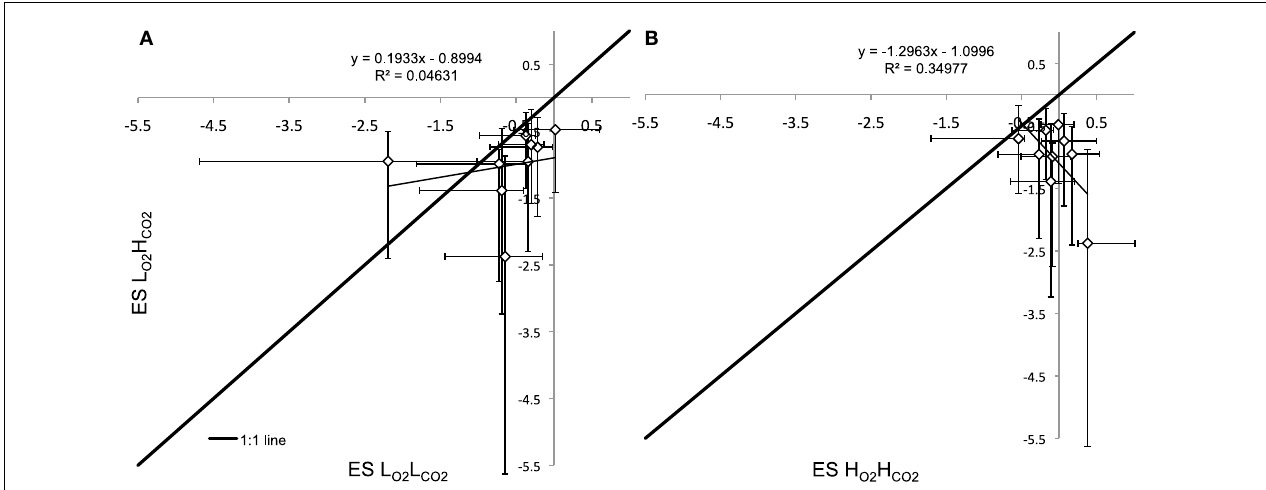
FIGURE 3 | Effect size off of the respiration rate of each species calculated with dry weight after 6 days. (A) L O2 H CO2 vs. L O2 L CO2 and (B) L O2 H CO 2 vs. H